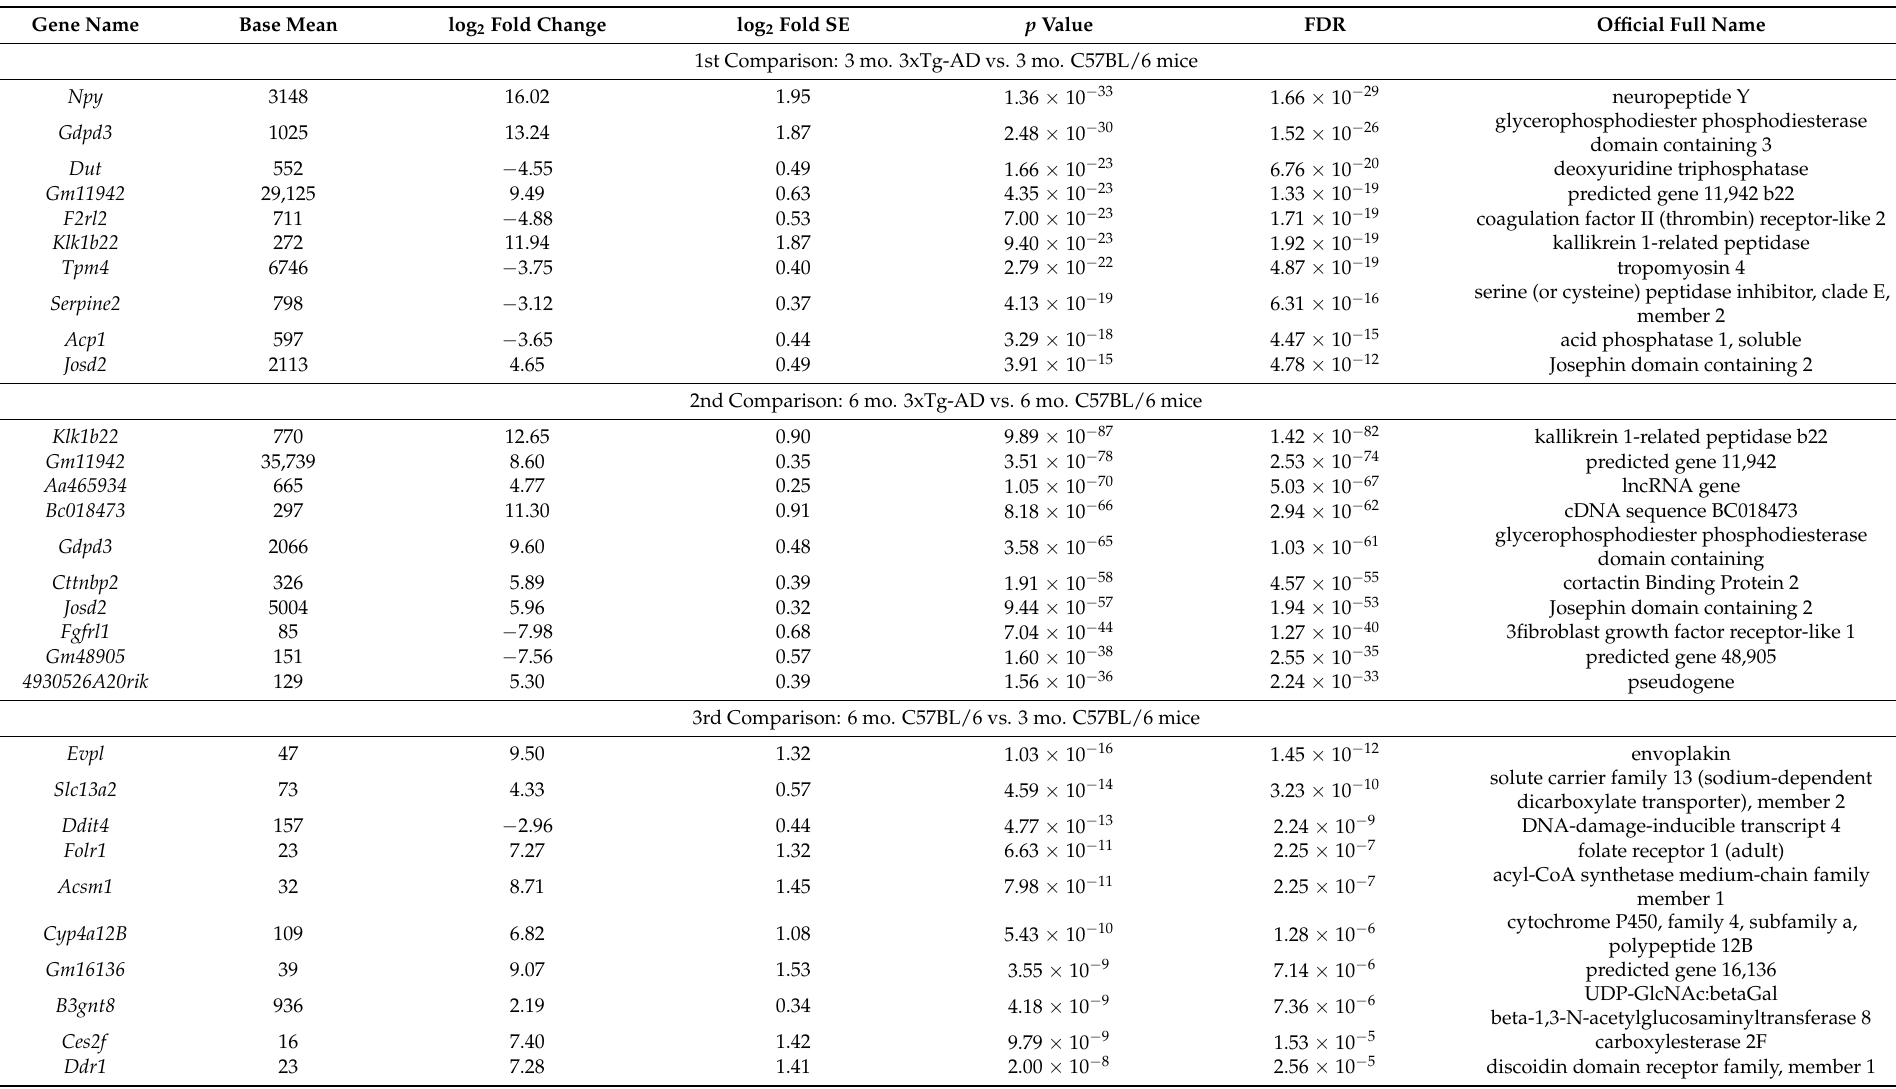
Table 2. List of top ten DEGs identified in the three comparisons. 1st Comparison: 3 mo. 3xTg-AD vs. 3 mo. C57BL/6 mice